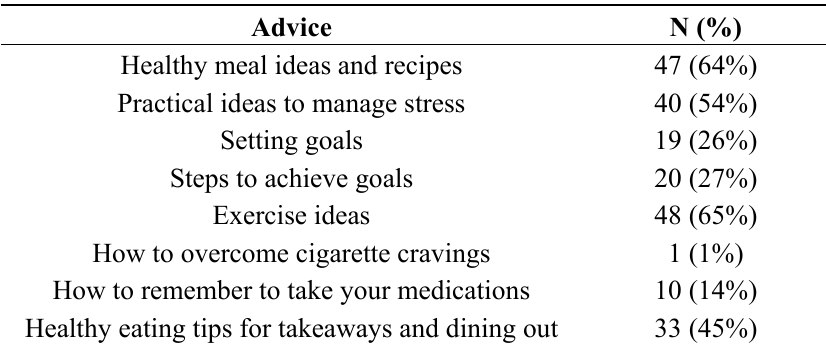
Table 4. Most useful cardiac rehabilitation